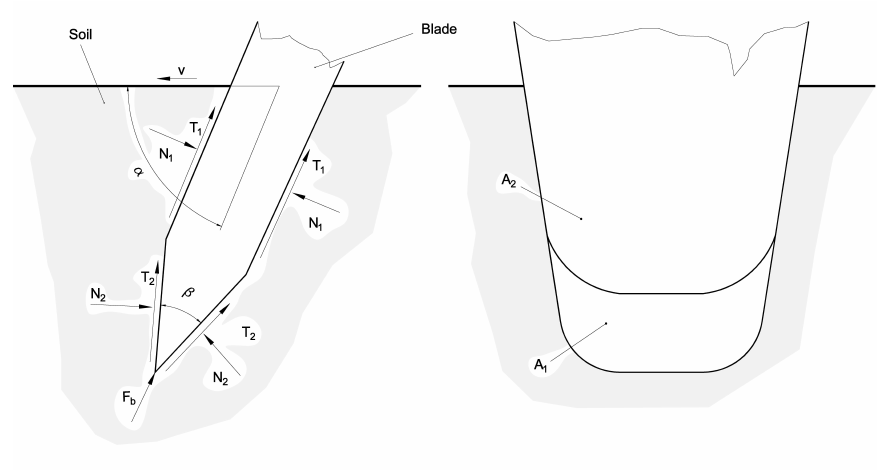
Figure 3. Conceptual determination of forces on spade (not to